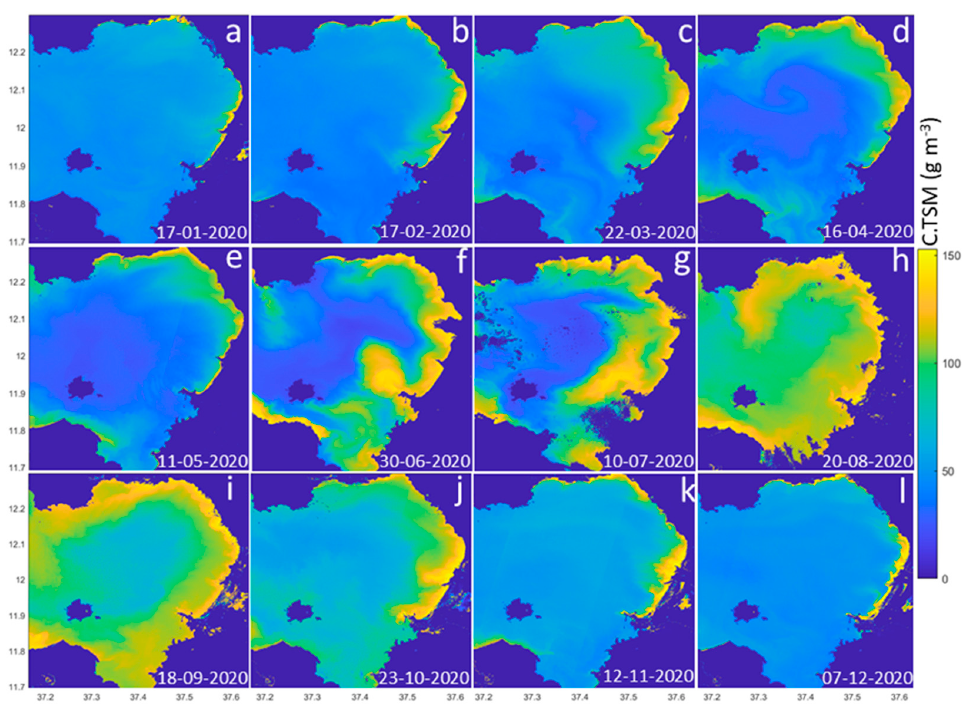
Figure 5. ( a )–( l ) Total suspended matter concentration (TSM, g m − 3 ) in Lake Tana from January 2020 to December 2020 estimated from the Sentinel ‐ 2 satellites after the C2RCC processor.